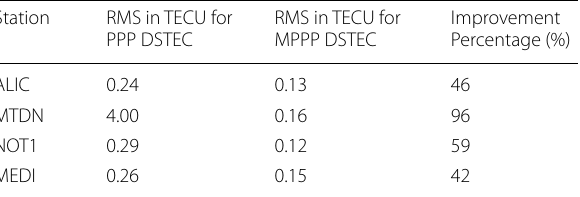
Fig. 7 Differences of DSTECs between the original PPP- (left column, Eqs. 5 and 6) as well as the MPPP-derived (right column, Eq. 10) STEC estimates and the STECs obtained from GF carrier phase observations. Different colors correspond to different satellites Table 2 RMS and improvement percentage of the MPPP-DSTEC